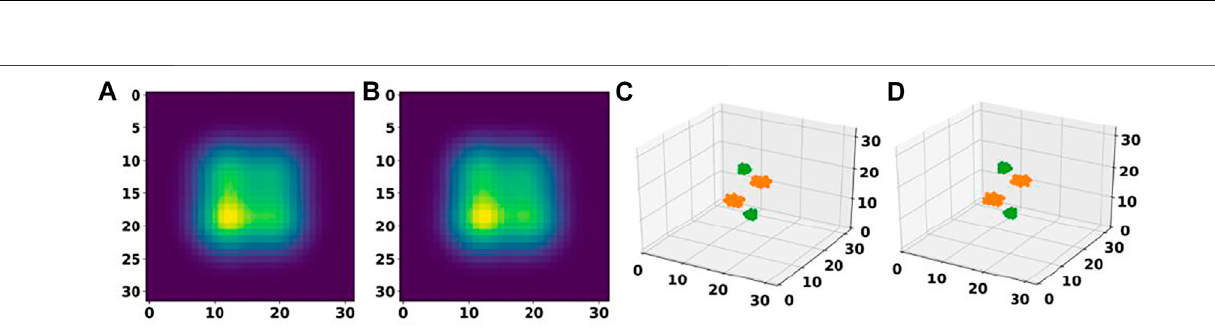
FIGURE6| Performanceofthesegmentationnetwork. (A) Predictedvs.truenumberofatomsinmaterialsfromthetestset. (B) Predictedvs.trueatomicnumbers of atoms in those materials that were predicted to have the correct number of atoms.